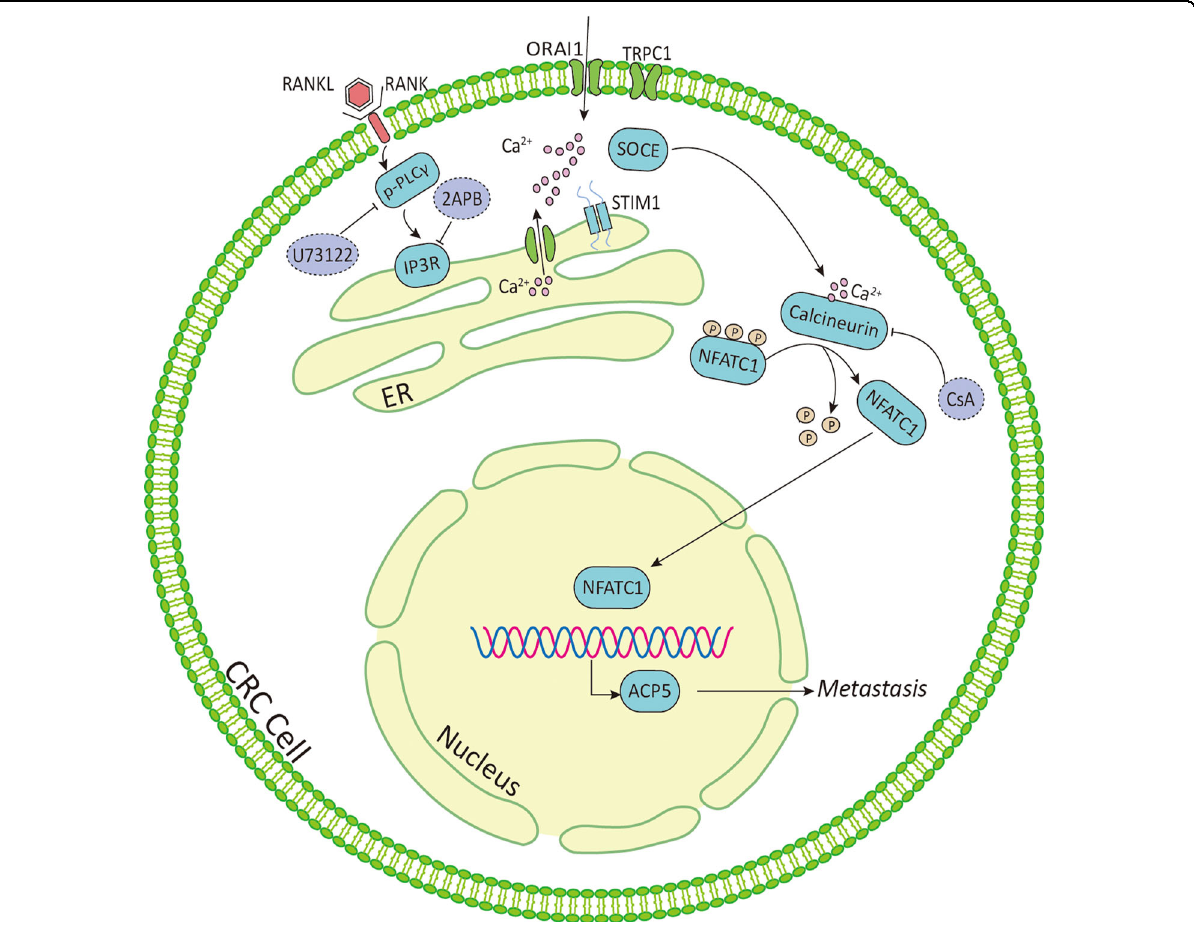
Fig. 8 Schematic summary. Active RANK expression allows for Ca 2 + release from ER dependent on PLC γ -mediated IP3R and Ca 2 + in fl ux from the extracellular milieu through STIM1-regulated SOCE. Besides, PLC γ -mediated IP3R axis act upstream of STIM1 to coactivate Ca 2 + oscillation. The Ca 2 + oscillation in the cytoplasm leads to calcium-dependent calcineurin activation and NFATC1 transcription of osteoclast-speci fi c gene, ACP5 , which promotes CRC metastasis. PLC γ phospholipase C γ , IP3R inositol-1,4,5-trisphosphate receptor, SOCE store-operated calcium entry, STIM stromal interaction molecule, TRPC transient receptor potential channel, NFATC1 nuclear factor of activated T cells c1, CsA cyclosporine A, 2APB 2- aminoethoxydiphenyl-borate, ACP5 tartrate-resistant acid phosphatase 5, ER endoplasmic